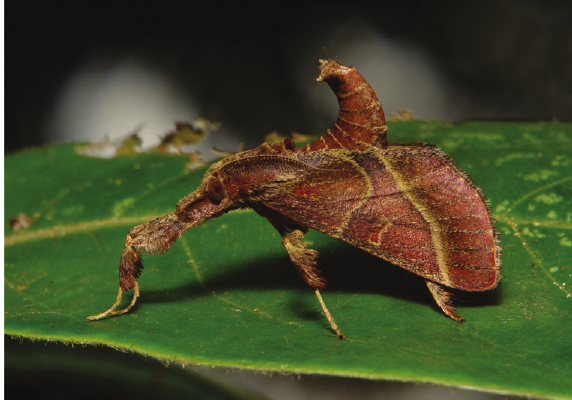
Figure 1. Sacada sp., showing the typical resting posture of male, and large hair tufts on fore- and midlegs. China, Yunnan, Pu’er, 25.6.2015, photo by John Horstman/ itchydogimages, used with